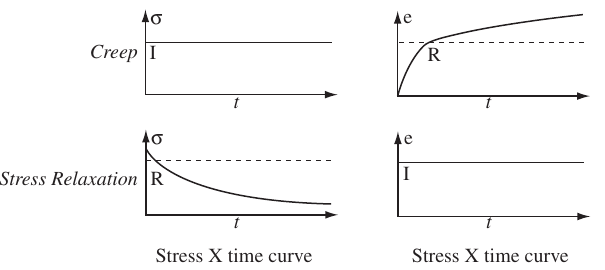
Figure 3. Schematic representation of output (R) to input (I) for creep and stress relaxation 27 .